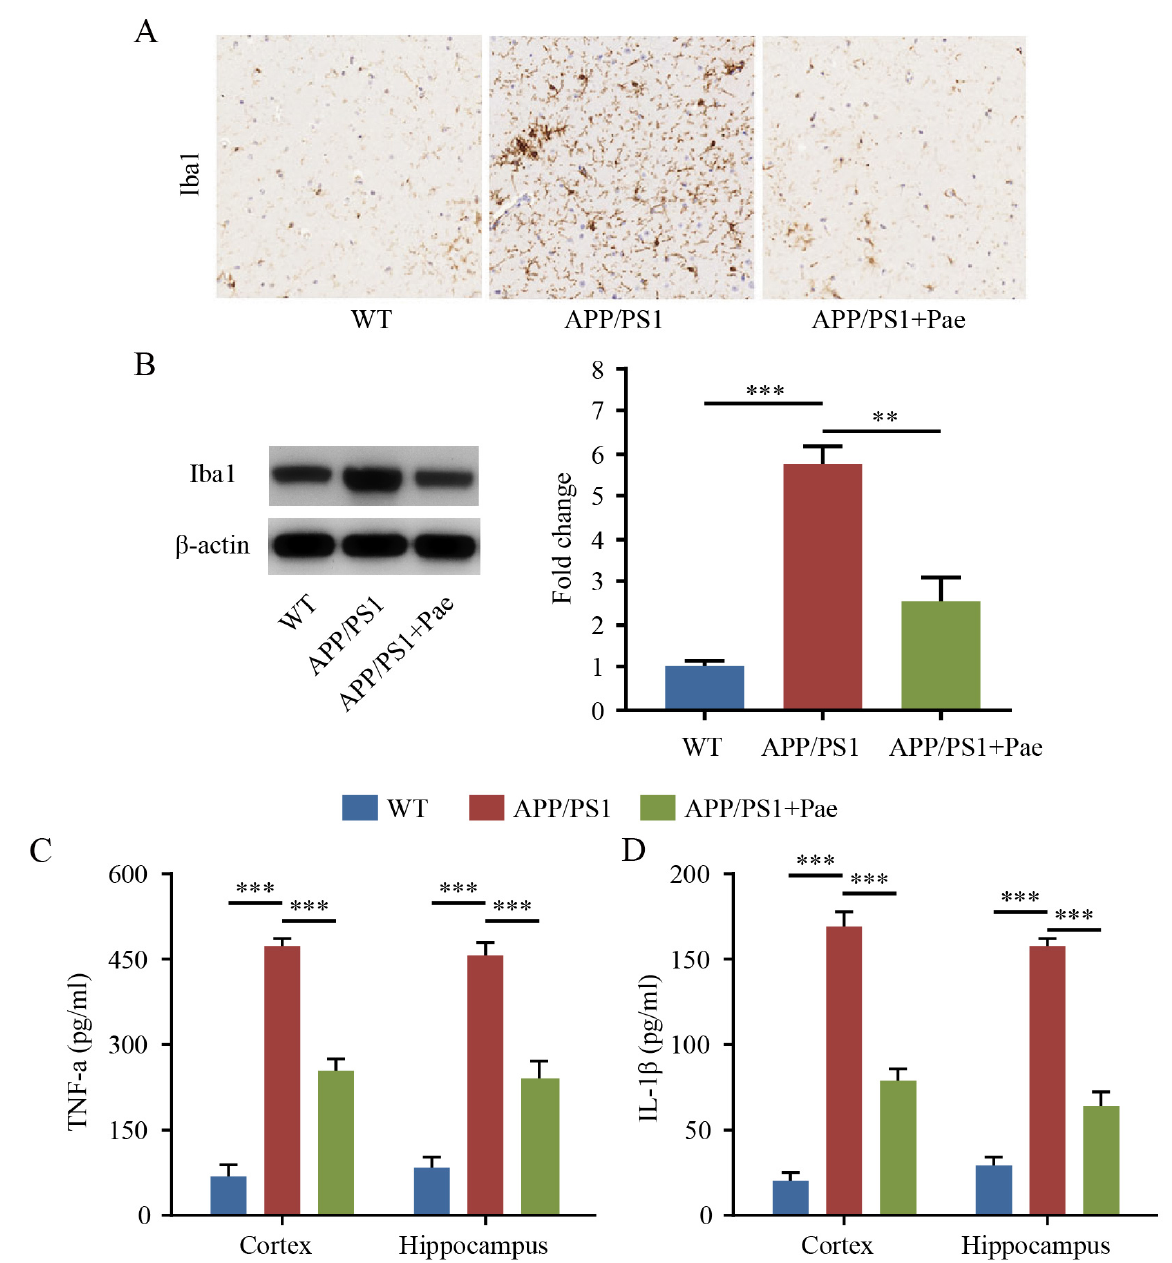
Fig. 3. Paeonol treatment caused microglia inactivation and decreased neuroinflammation in APP/PS1 mice. (A) Immunohistochemistry for mi- croglia markers ionized calcium-binding adapter molecule 1 (Iba1) in the hippocampus. Scale bars, 20 µ m. (B) Western blot band results of Iba1 expression and (E–G) the results of statistical analyses. (C,D) TNF- α and IL-1 β levels in the cortex and hippocampus were detected by ELISA. Mean ± SEM was shown (n = 5 mice). ** p < 0.01, *** p <